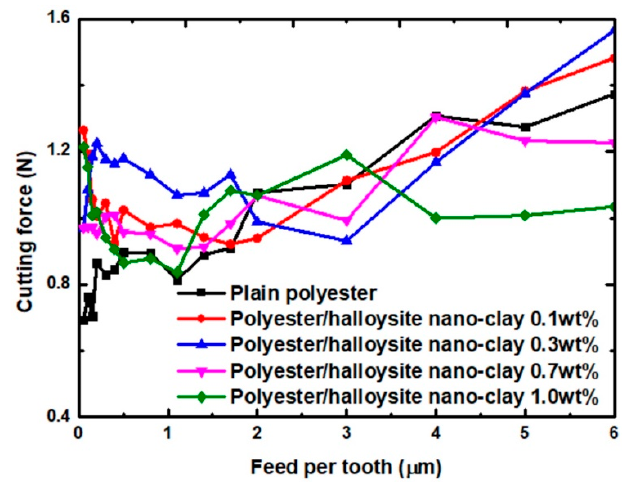
Figure 10. Effect of feed per tooth (FPT) value on cutting force.